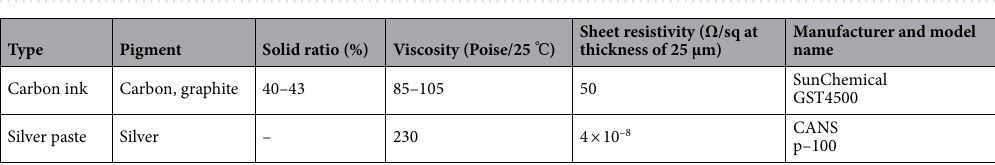
Table 2. Properties of the conductive carbon ink and the silver